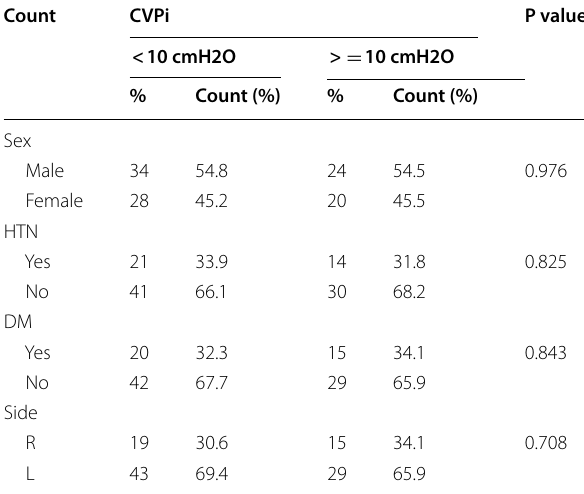
Table 1 Showing no significant correlation between the patient sex, presence of DM, presence of HTN or the examined side, and between CVPi